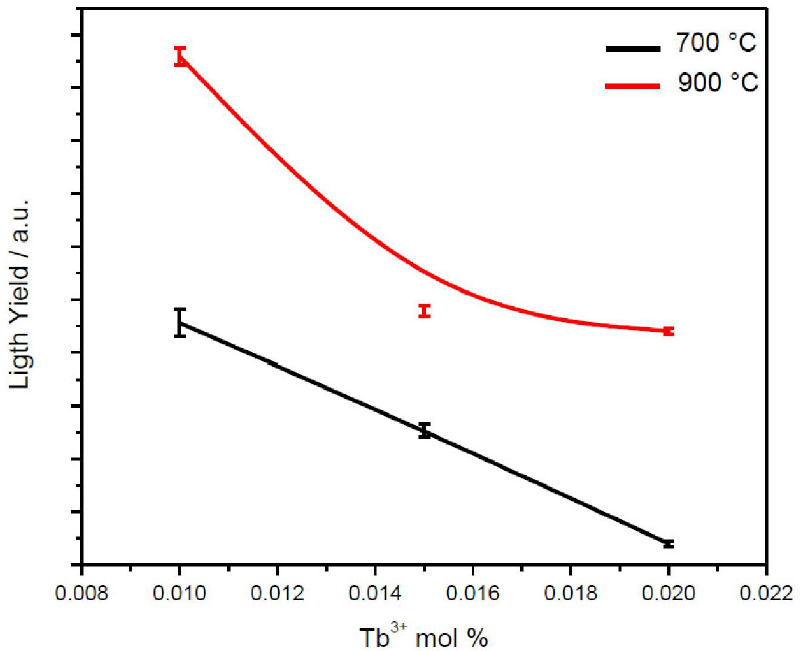
Figure 7. Evolution of the scintillating light yield of Lu powders annealed at 700 and 900 °C as a function of Tb 3+